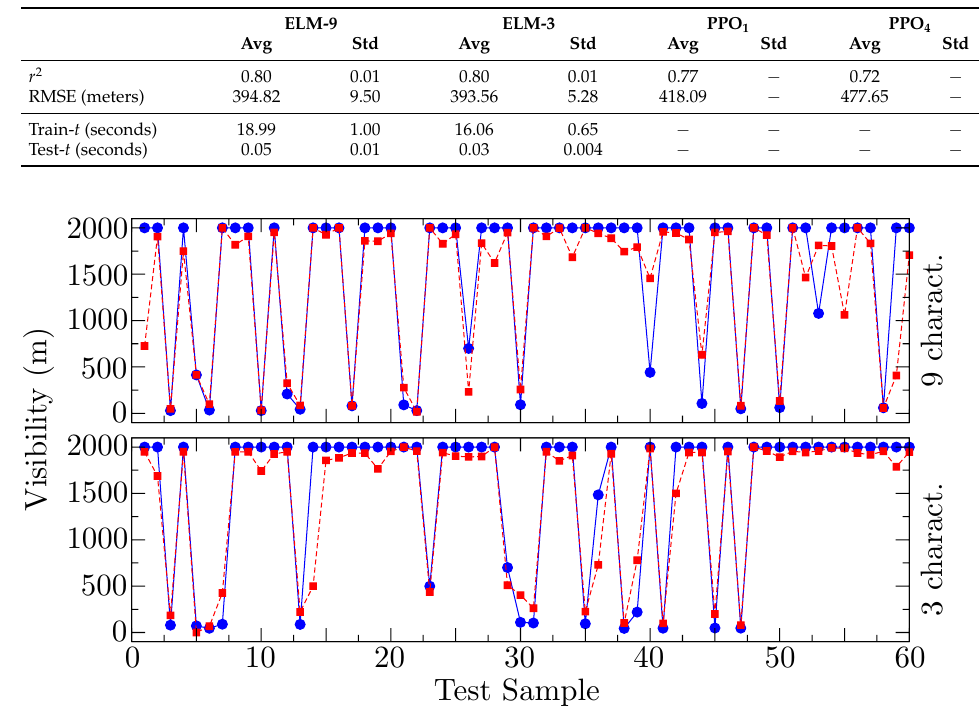
Figure 9. Time-series of measured (blue) and predicted (red) visibility values by the ELM with 9 and 3 features (input